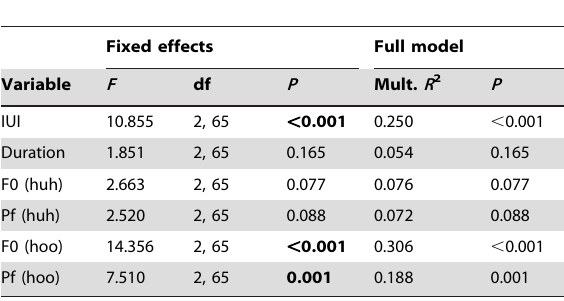
Table 5. Variation in relation to male age